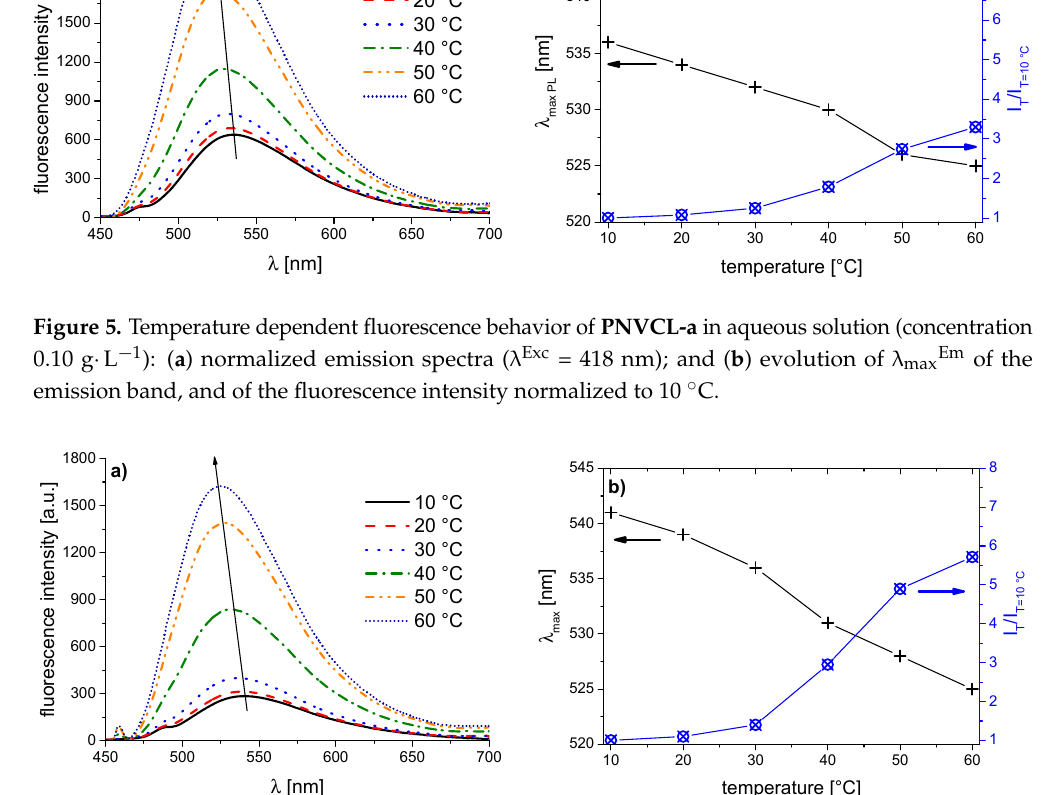
Figure 6. Temperature dependent fluorescence behavior of PNVCL-b in aqueous solution (concentration 0.10 g·L − 1 ): ( a ) normalized emission spectra ( λ Exc = 418 nm); and ( b ) evolution of λ maxEm of the emission band, and of the fluorescence intensity normalized to 10 °C.